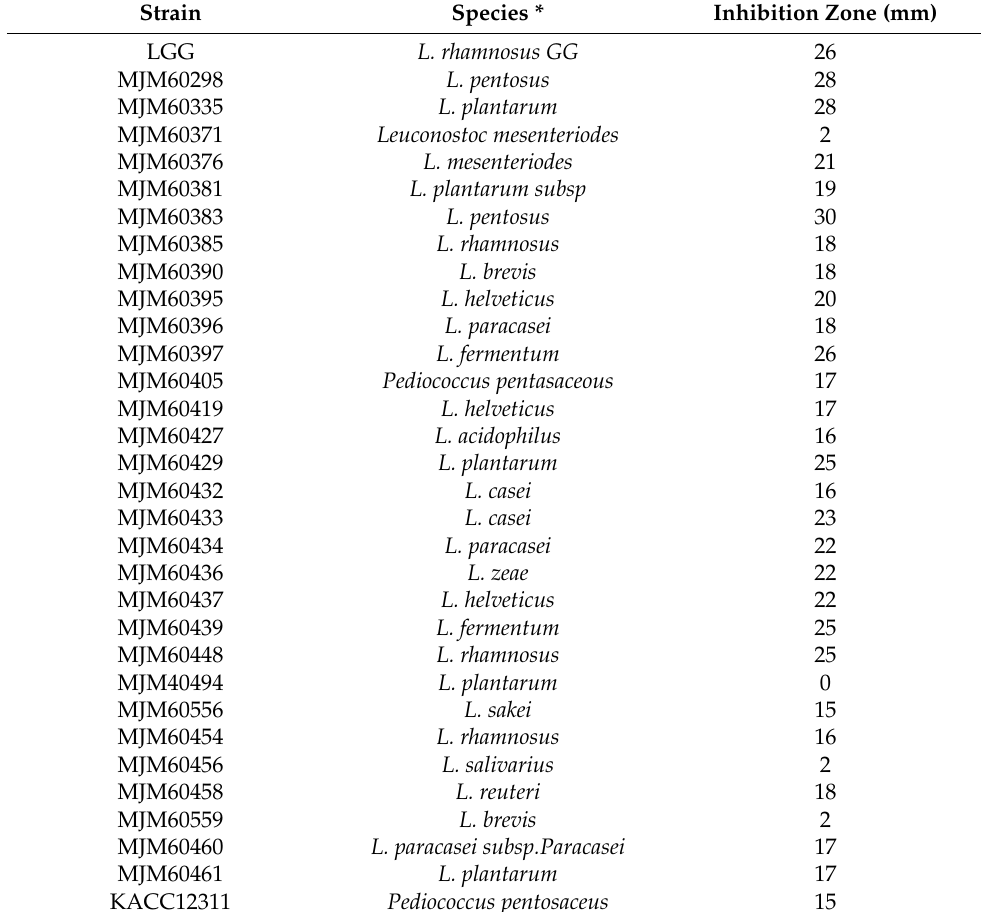
Table 1. Antagonistic activity of LAB against E. cloacae